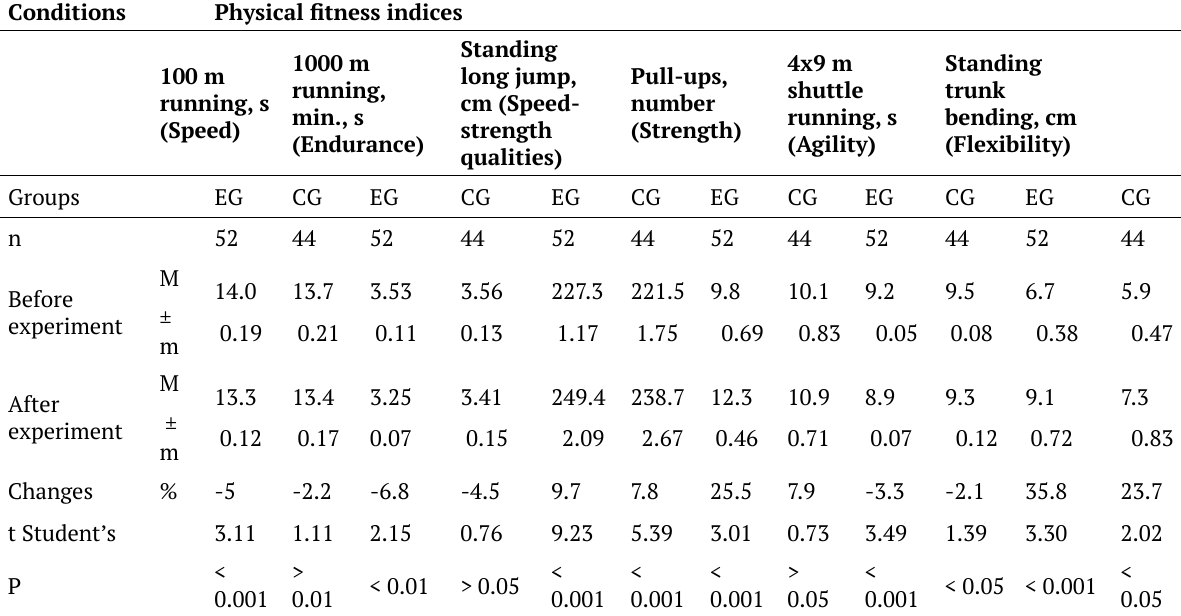
Table 1. Comparative characteristics of physical fitness indices of the 1st year young men of CG and EG before and after the pedagogical experiment